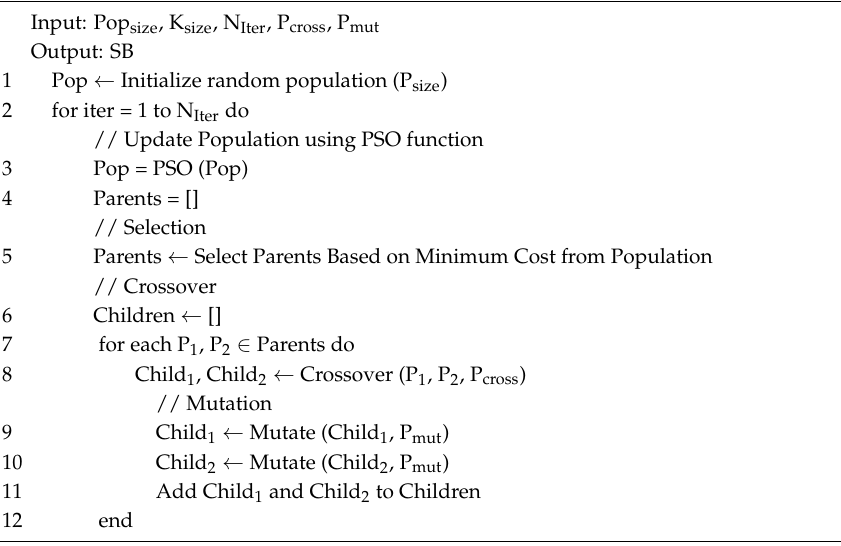
Algorithm 1. Algorithm for Obtaining Optimal Load